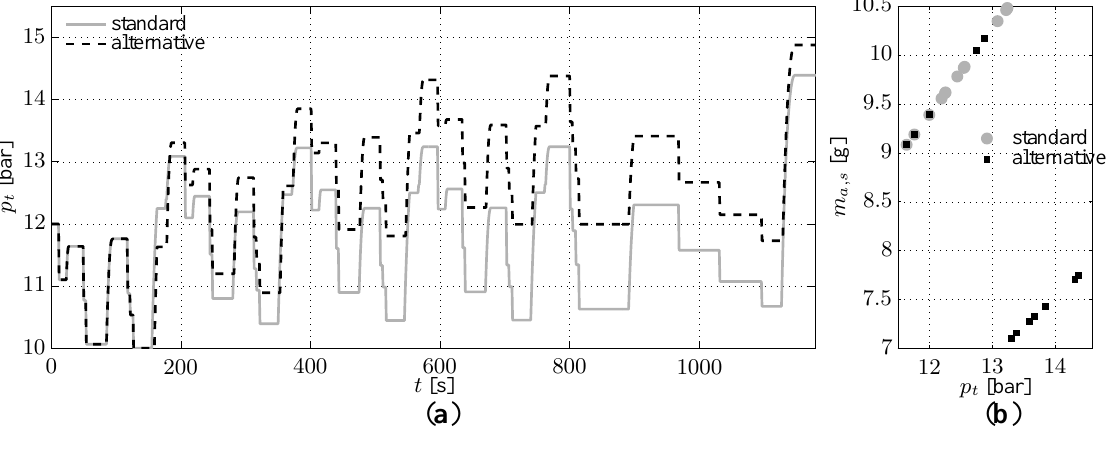
Figure 11. ( a ) Tank pressure trajectories for the gear profiles considered on the entire drive cycle and ( b ) air mass consumption of the various engine starts. V